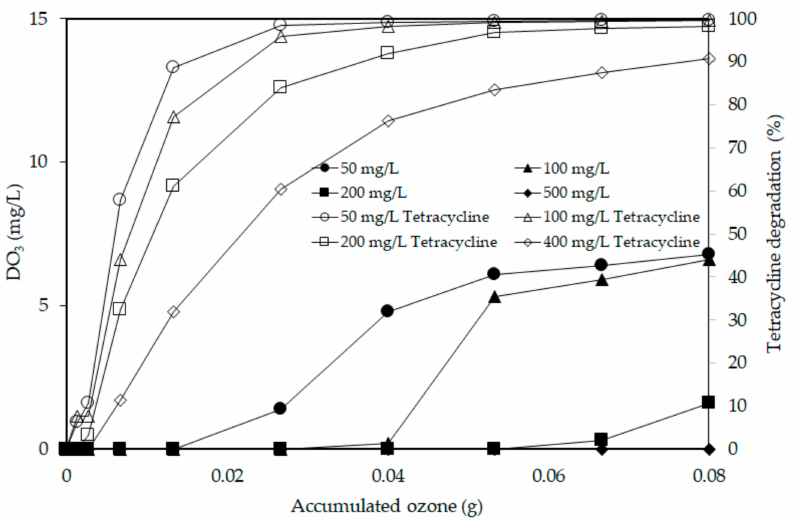
Figure 6. Tetracycline degradation percentage and dissolved ozone concentration during ultrafine- bubble ozonation at different initial tetracycline